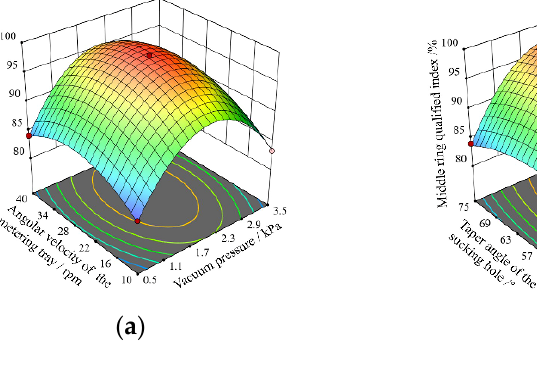
Figure 7. Effect of ( a ) angular velocity of metering tray and vacuum pressure, ( b ) taper angle of sucking hole and vacuum pressure, and ( c ) taper angle of sucking hole and angular velocity of metering tray on the middle ring qualified index.